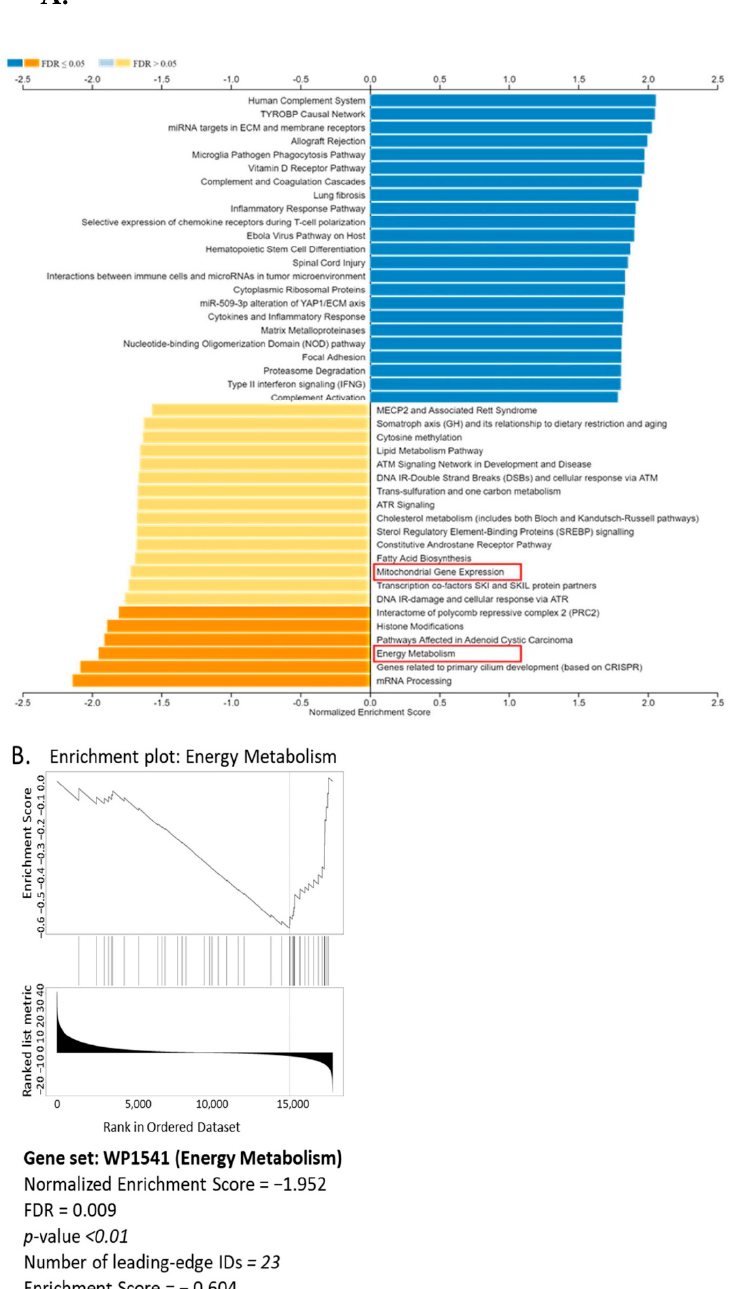
Figure 1. ( A ). Visualization of TIMP-1 enriched pathways through Wikipathways in TCGA lung cancer dataset. Red box: Further explored in manuscript. ( B ). GSEA plot of energy metabolism gen- eset.